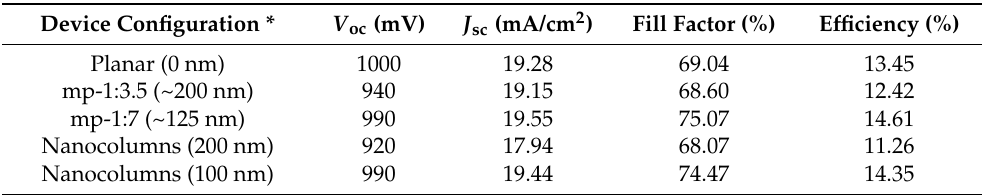
Table 1. J-V characteristics parameters of best-performing device based on MAPbI 3 perovskite with different electron selecting layer. * The value in parenthesis depicts the thickness used.